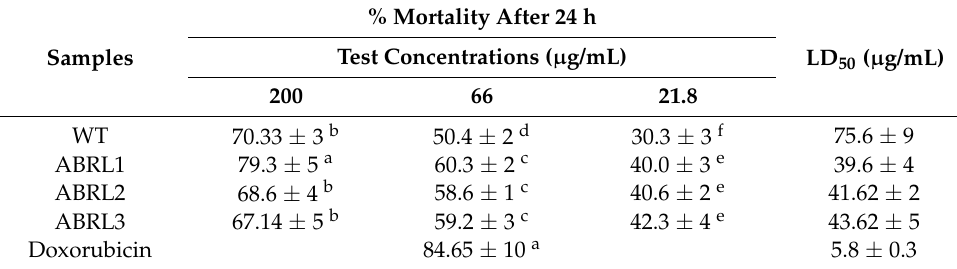
Table 4. Brine shrimp cytotoxicity of Ajuga bracteosa .